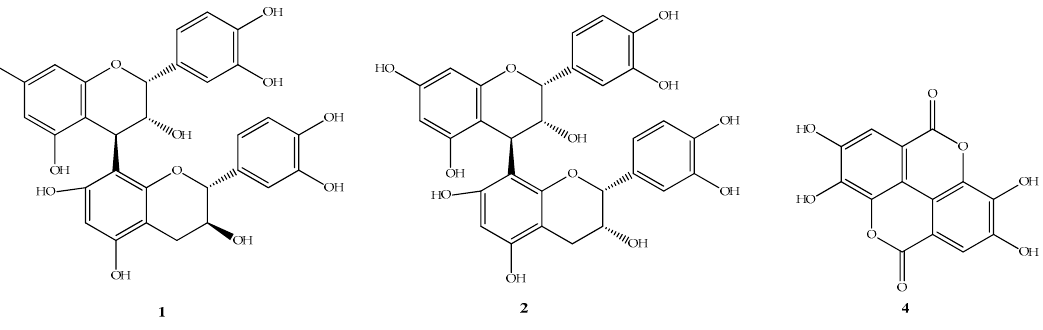
Figure 2. Structures corresponding to the identified compounds in the fractionation of the fraction F.EtOAc.2 of P. friedrichsthalianum : ( 1 ) procyanidin B1; ( 2 ) procyanidin B2; and ( 4 ) ellagic acid.